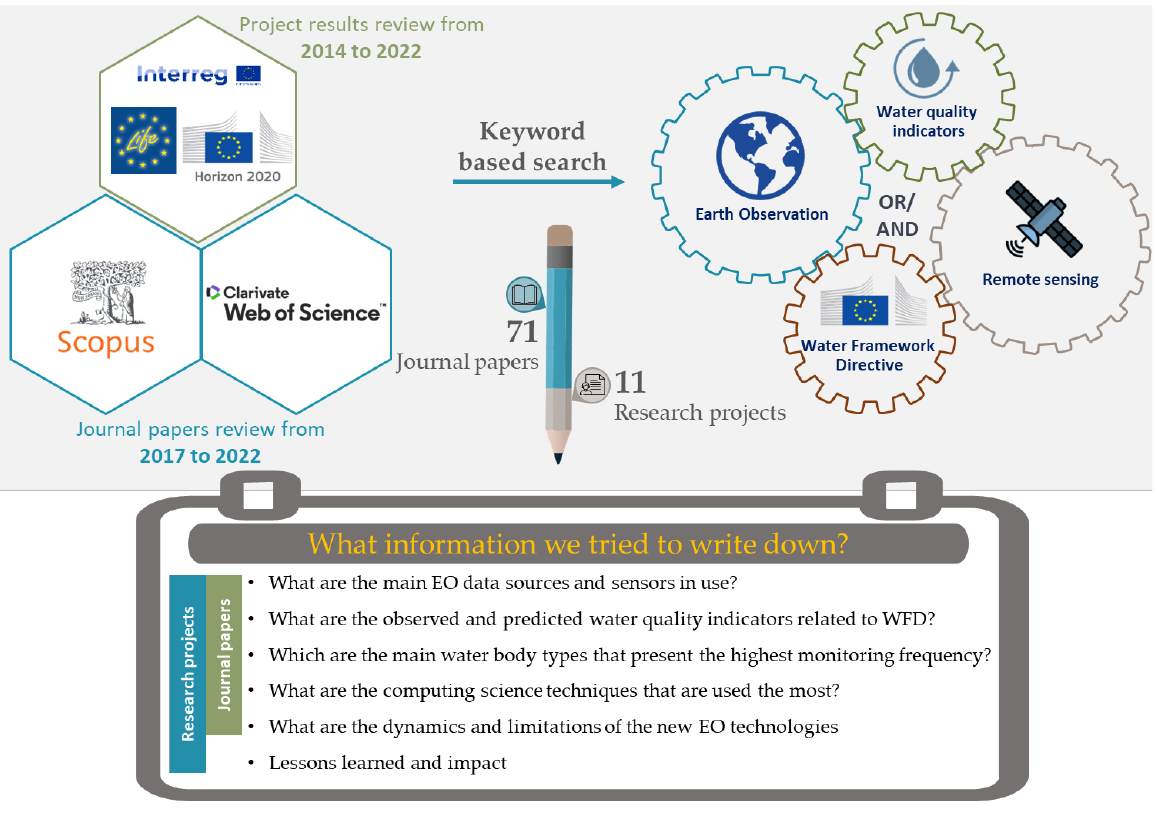
Figure 2. An overview of our review process .